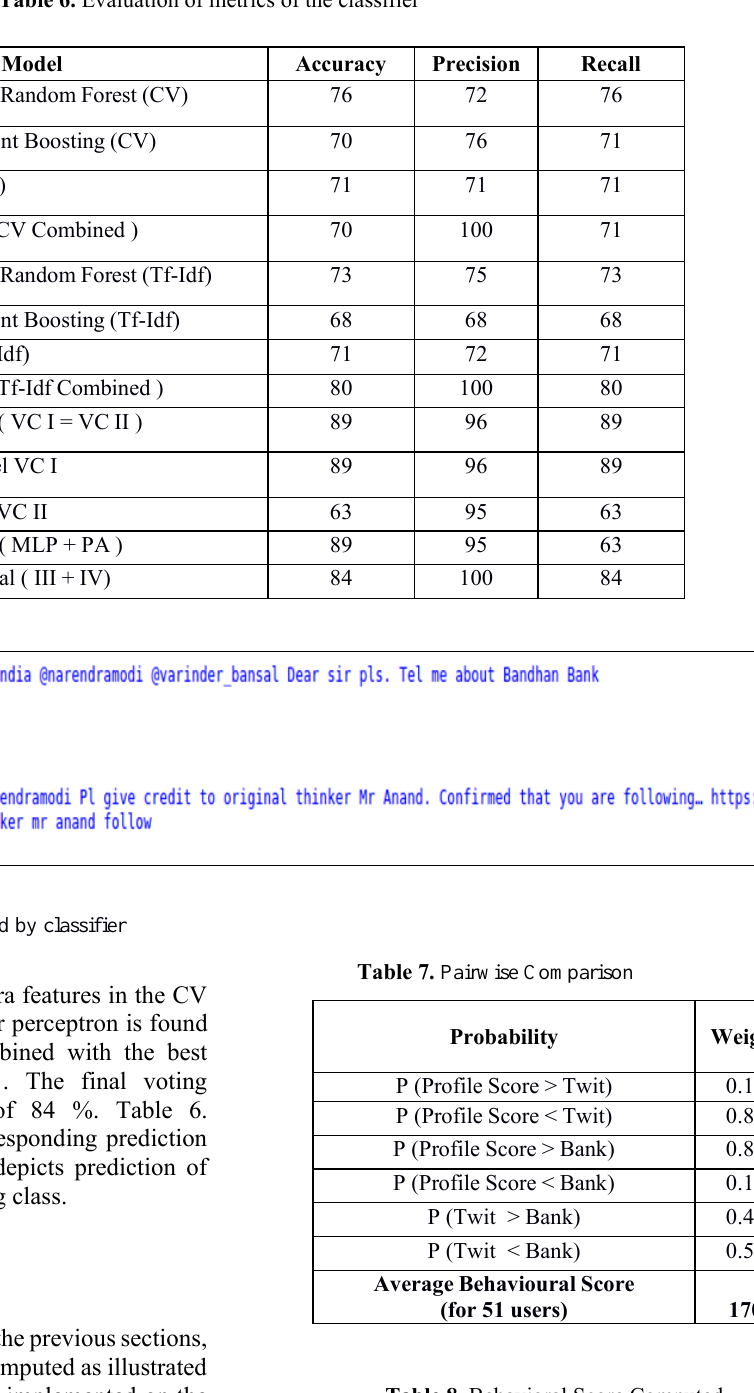
Table 6. Evaluation of metrics of the classifier